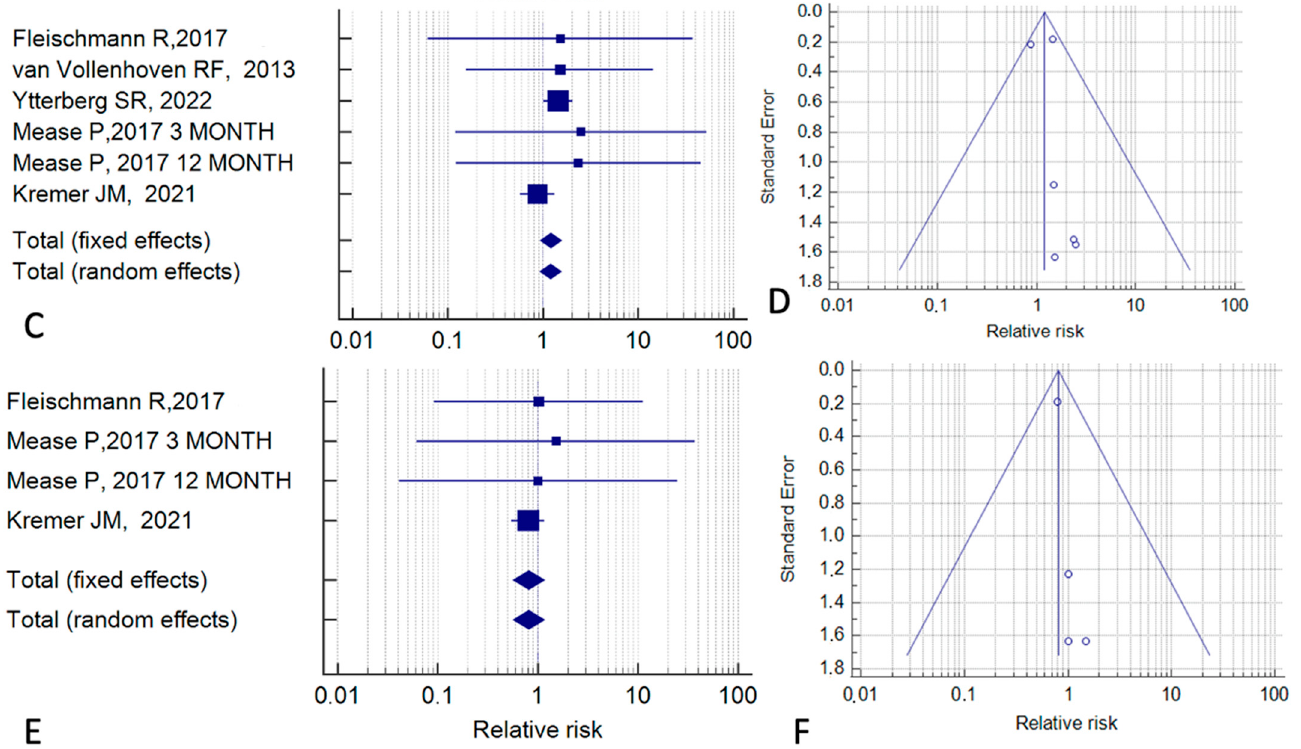
Figure 6. Cancer risk associated with tofacitinib treatment relative to treatment with biological drugs. ( A , B ) All cancers. ( C , D ) All cancers except non-melanoma skin cancer. ( E , F ) Non-melanoma skin cancer. ( A , C , E ) Forest plots of relative risk. ( B , D , F ) Funnel plots for the assessment of publication bias [15,21,24,35,39].